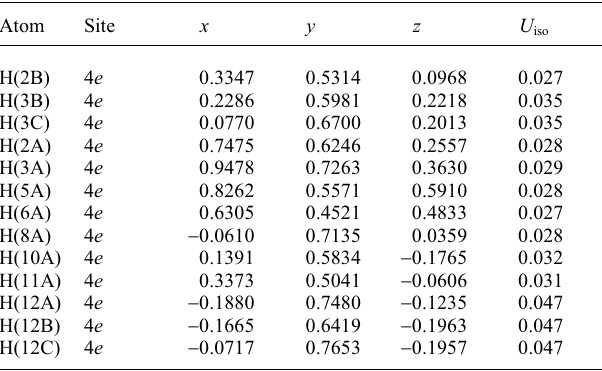
Table 2. Atomic coordinates and displacement parameters (in Å 2 ) .